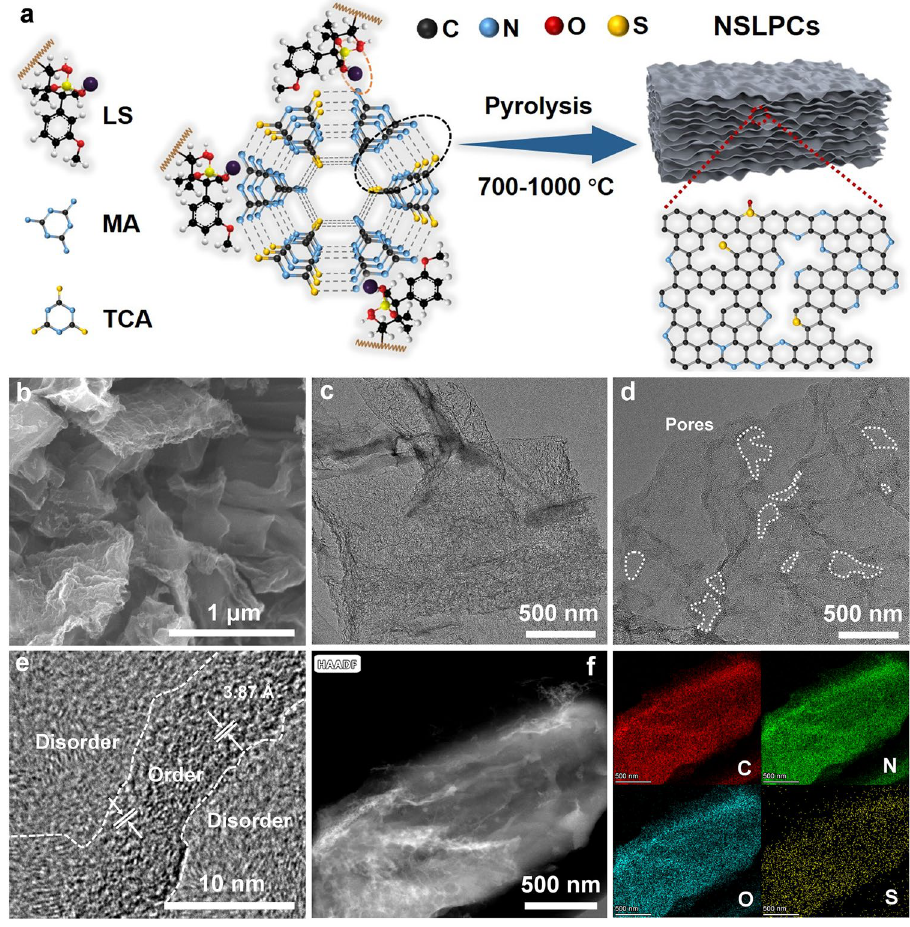
Fig. 2 a Schematic illustrating the preparation of NSLPCs. b SEM image of NSLPC-700. ( c‑e ) TEM images of NSLPC-700. f EDS elemental mapping of